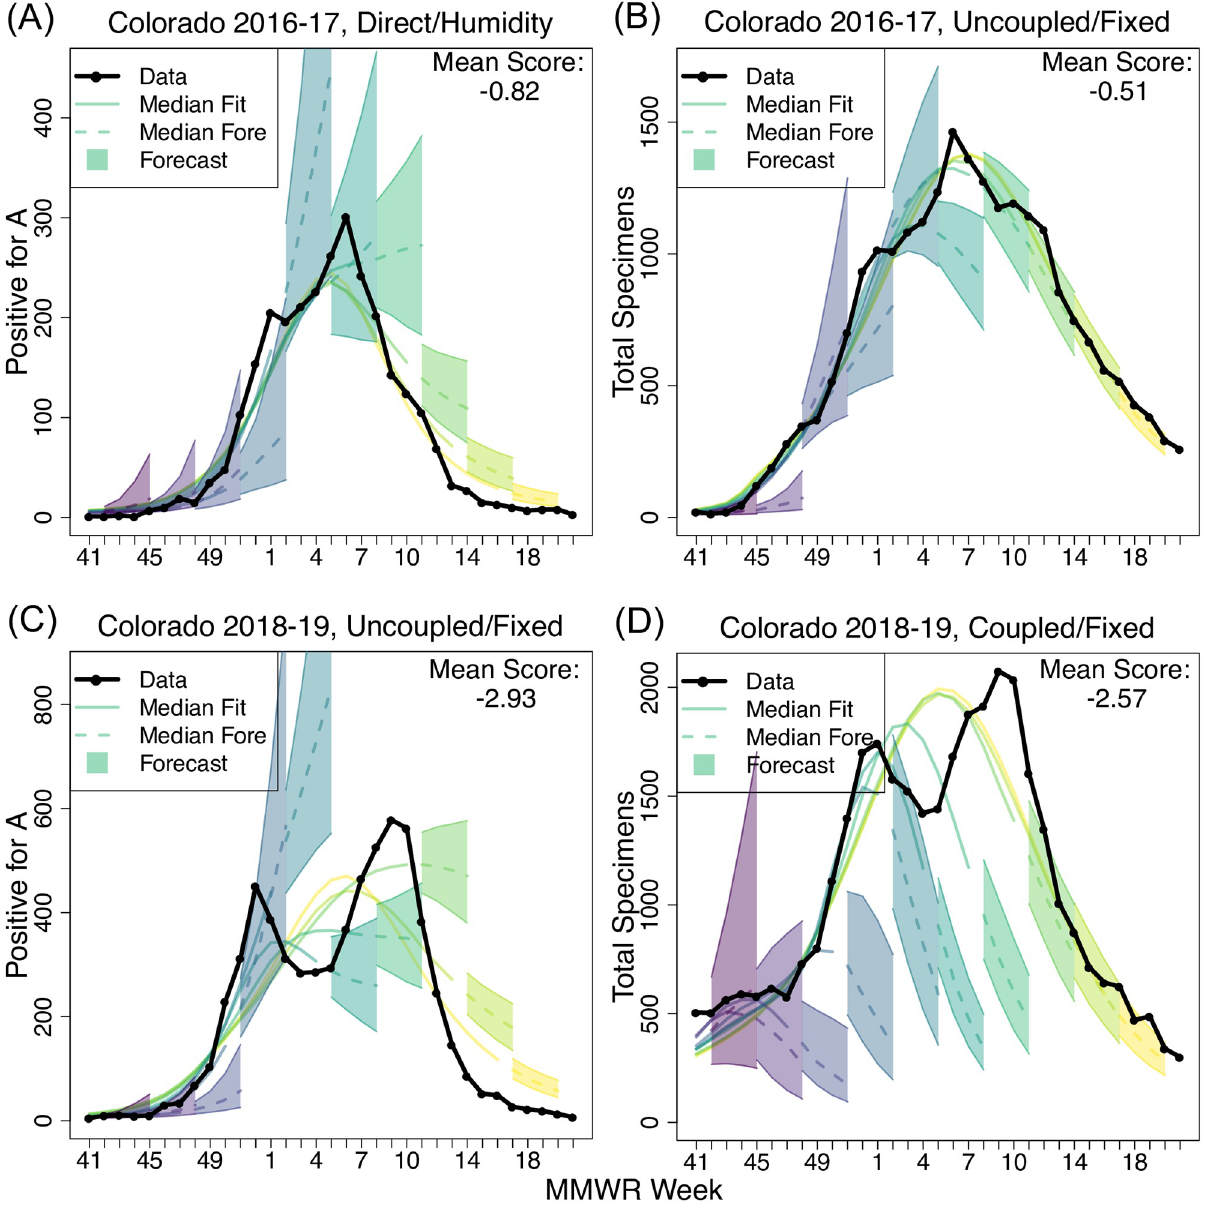
Fig 4. Illustrative high-scoring and lower-scoring forecasts for the Colorado cluster. Here the incidence data is shown in black and shaded cones depict the central 50% forecast windows for 1–4 week ahead. Forecasts were generated for every week, but only every third forecast is shown here for clarity. Colour progression from left to right indicates time of forecast. Solid lines show fit to data at the point the forecast was assumed to have been made. Dashed lines show forecasts beyond the time at which data were assumed to be available. Mean score is the average score across MMWR forecasted weeks and 1 to 4 weeks ahead